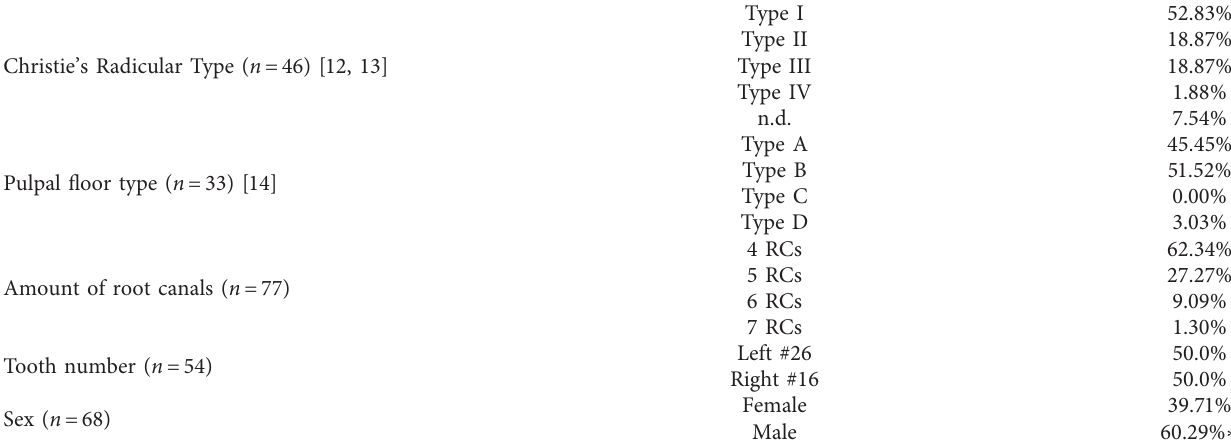
Table 3: Evaluation of different anatomical characteristics, classification, and